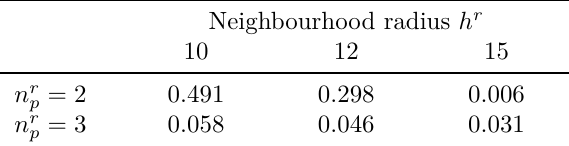
Table 3. Values of the volume fraction error ε φ , depending on neighbourhood radius h r and pooling size n r p . Table 4. Values of the two-point probability error ε S 2 , depending on neighbourhood radius h r and pooling size n r p .